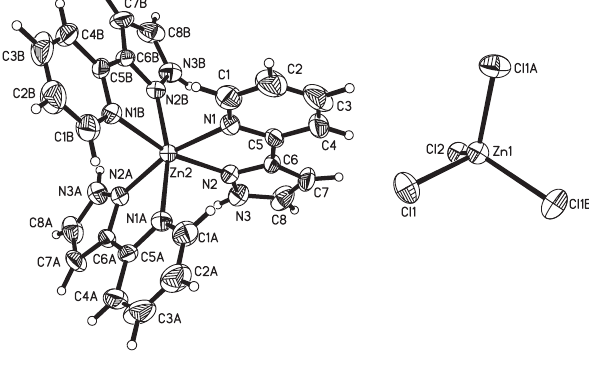
Table 2: Atomic coordinates and displacement parameters (in Å 2